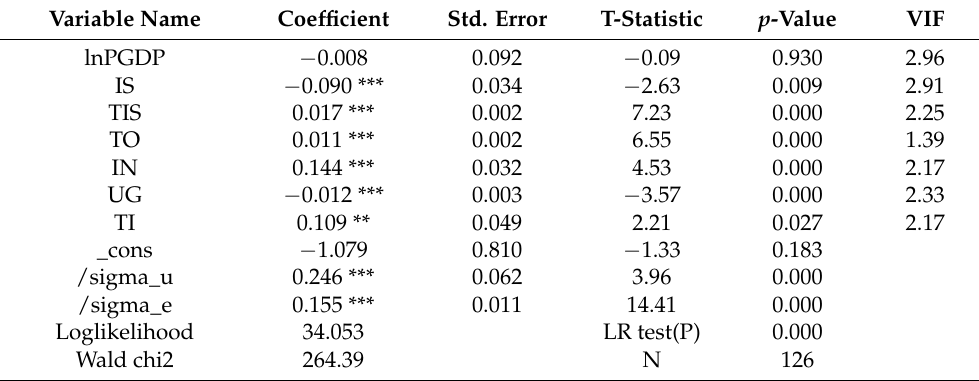
Table 3. Estimated results of the Tobit